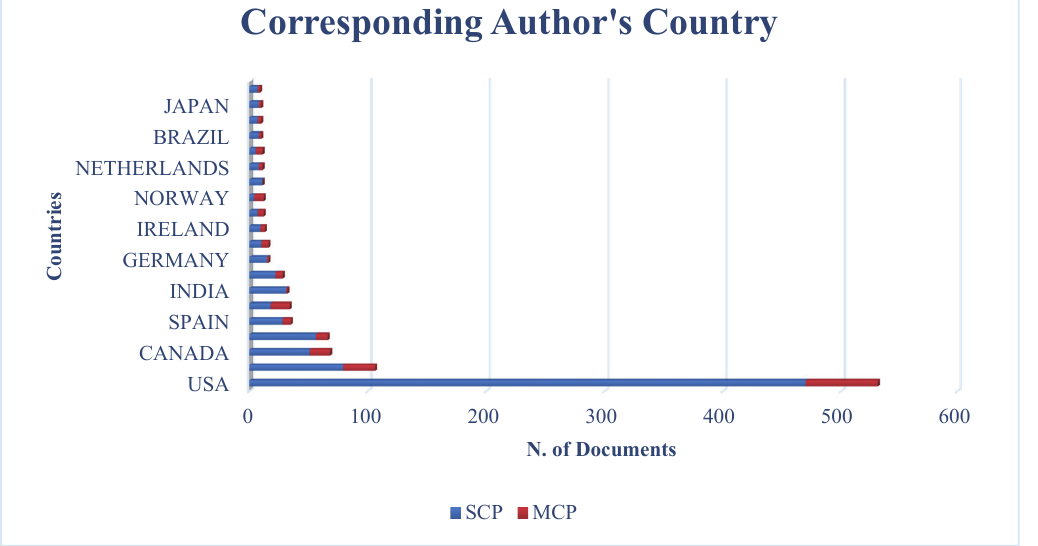
Fig. 2. Corresponding author's country